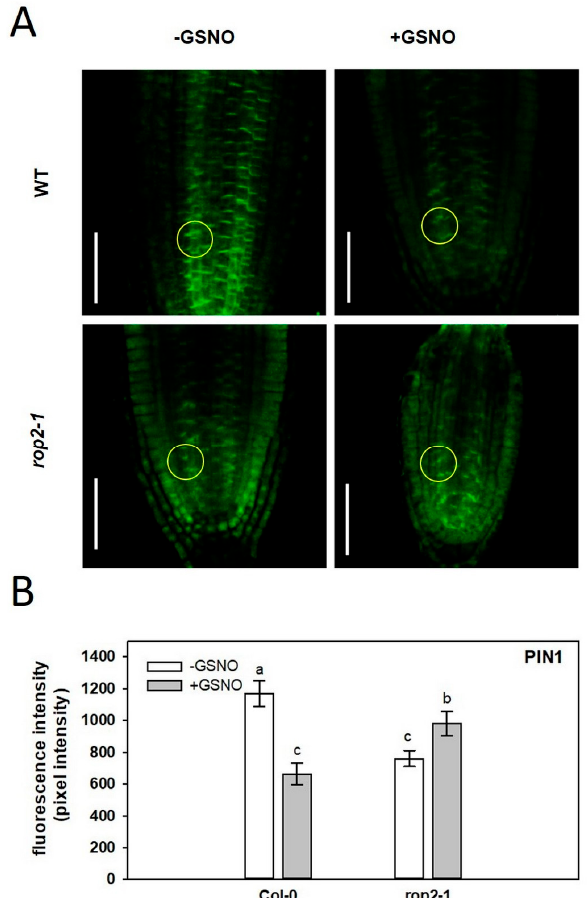
Figure 5. ( A ) Immunofluorescence localization of the PIN 1 protein in PR meristem of control (-GSNO) and 250 µ M GSNO-treated wild type (WT) and rop2-1 Arabidopsis seedlings. Bars = 50 µ m. ( B ) Intensity of PIN1-associated whole-mount immunofluorescence in the PR meristem of wild-type and rop2-1 Arabidopsis grown without or with 250 µ M GSNO. Pixel intensities were measured in the stele in circle areas with 25 µ m radii at 50 µ m distance from the quiescent center cells (encircled). Different letters sign significant differences according to ANOVA and Duncan’s test (n = 20, p ≤